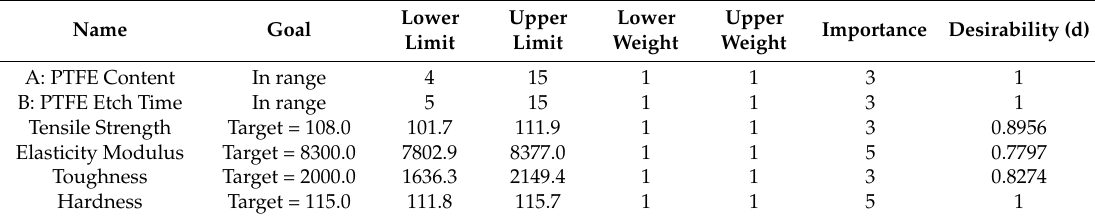
Table 7. Specification for factors and responses with weightage and importance.